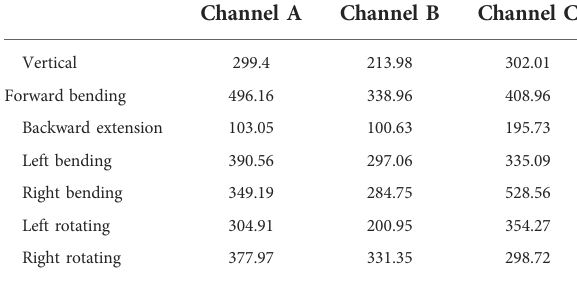
TABLE 5 Maximum von mises stress of internal fi xation with three channels